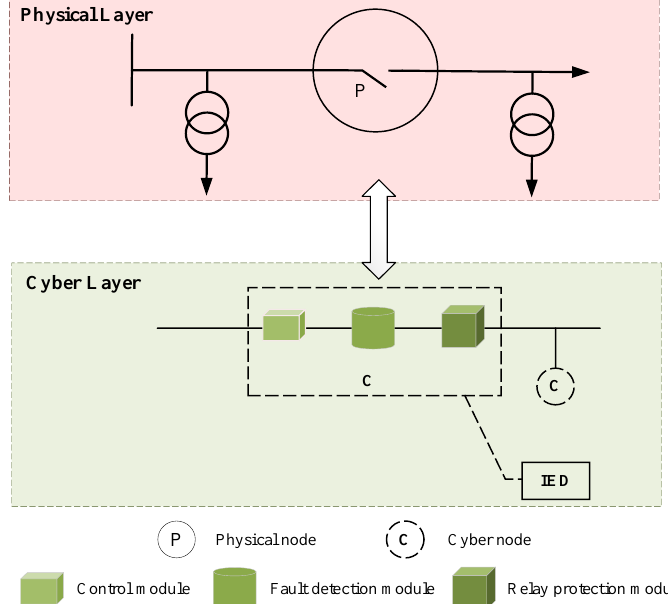
Figure 2. Schematic diagram of the cyber–physical interface IED model.